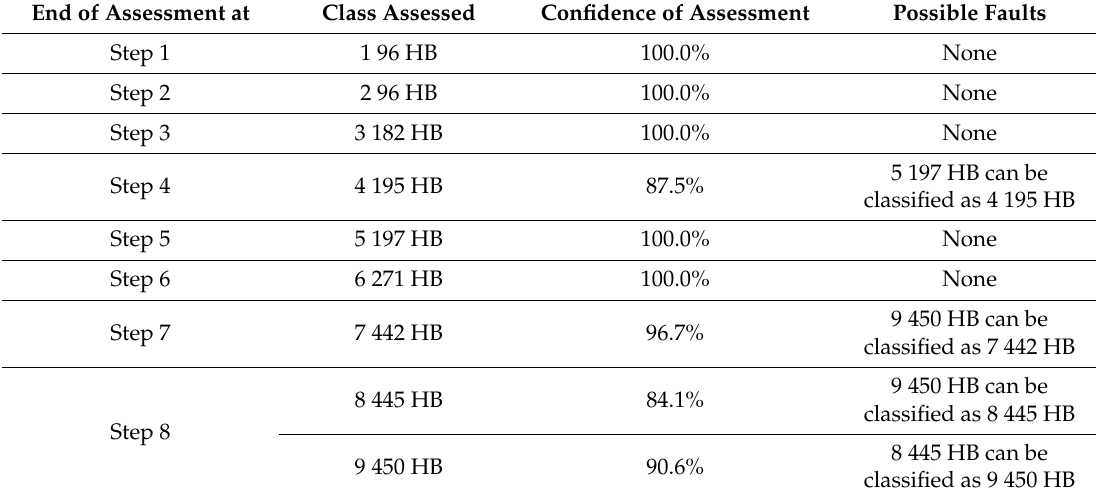
Table 6. Result of classifications by an ensemble of ANNs for each